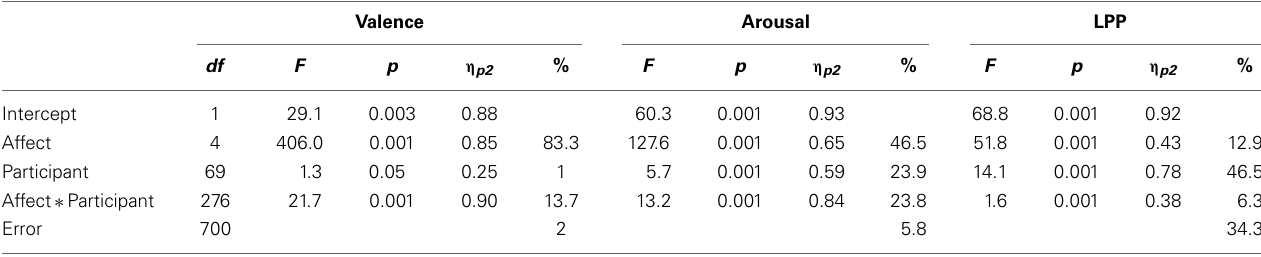
Table 1 | Results of mixed model ANOVAs of affective ratings and LPP